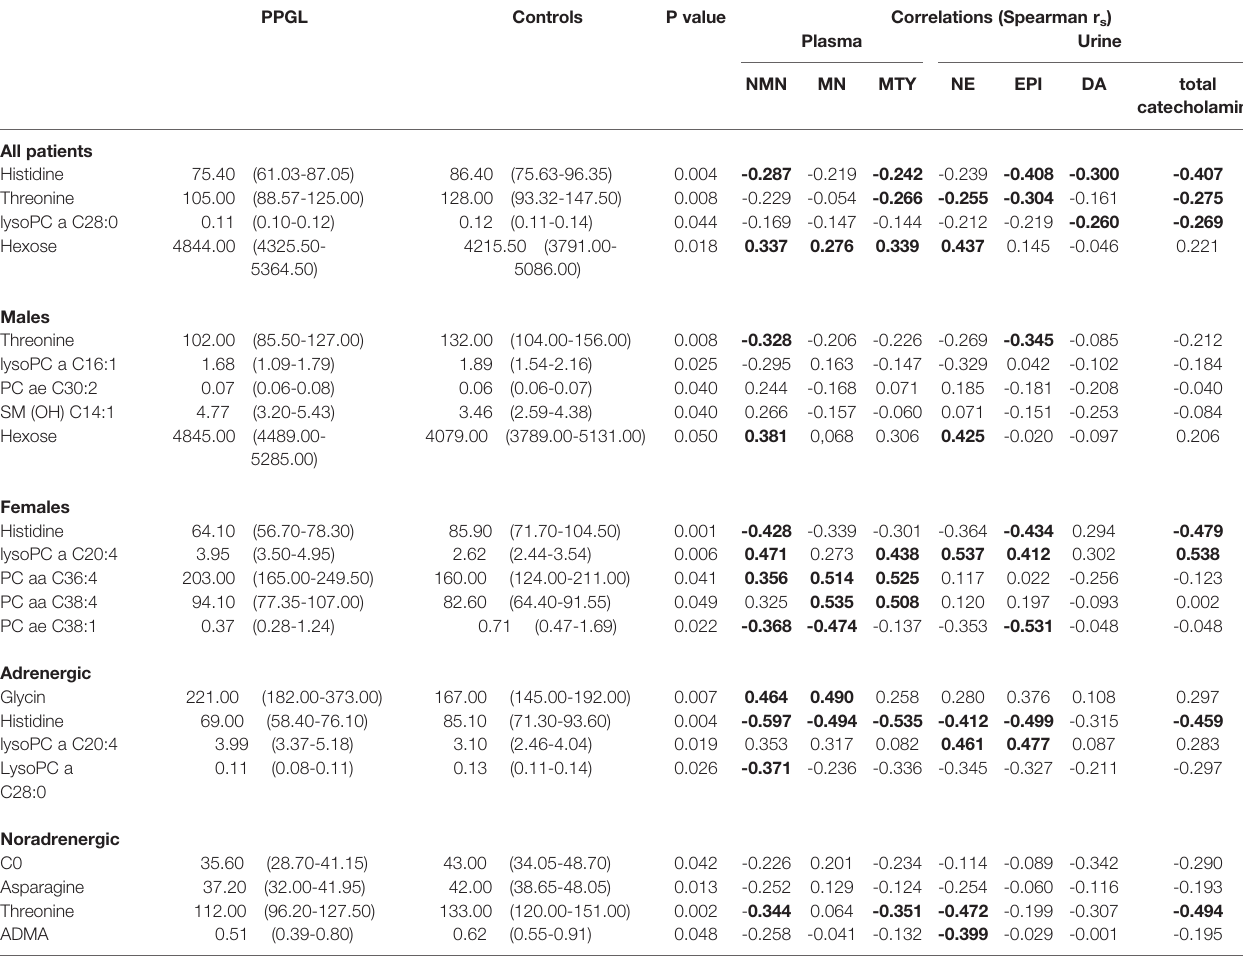
TABLE 2 | Plasma levels of signi fi cant altered metabolites (p ≤ 0.05) in patients with PPGL in comparison to controls including subgroup analysis and the correlation with free plasma metanephrines and 24h urinary free catecholamine excretion values. PPGL Controls P